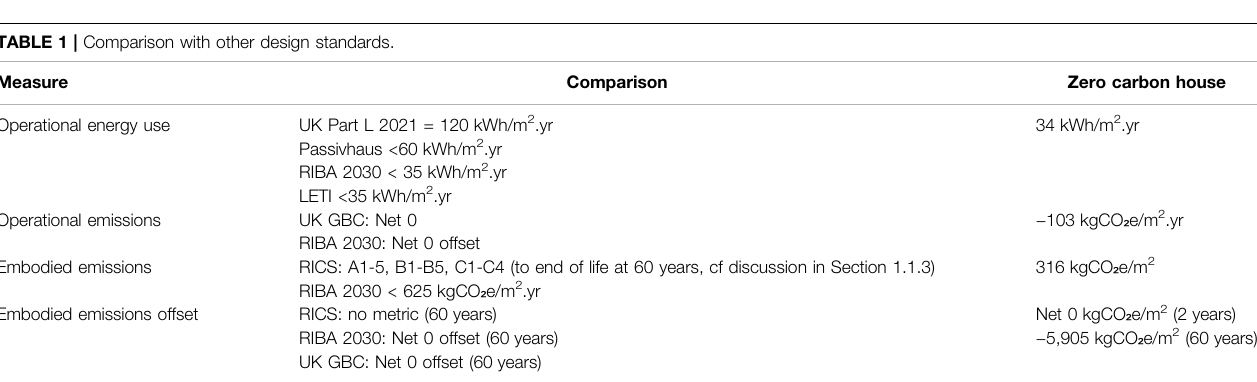
TABLE 1 | Comparison with other design